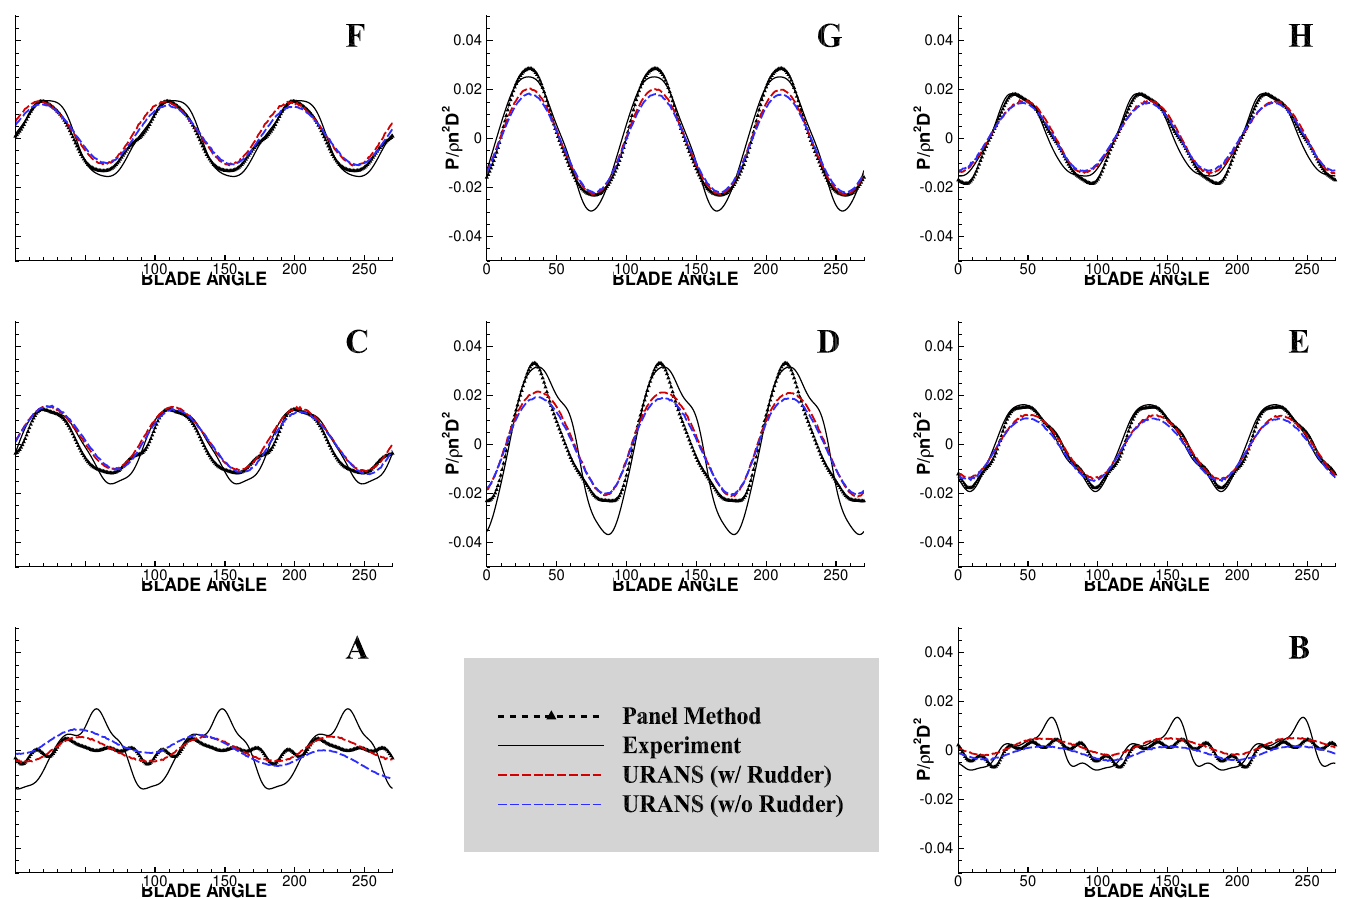
Figure 34. Comparisons of the hull pressures ( P / ρ n 2 D 2 ; y axis) in wetted condition between the pressure-BEM, RANS, and the experiments during the three-fourths period of propeller revolution. Results are only shown between 0 ◦ to 270 ◦ in blade angle ( x axis). Locations of the transducers ( A – H ) are indicated in the